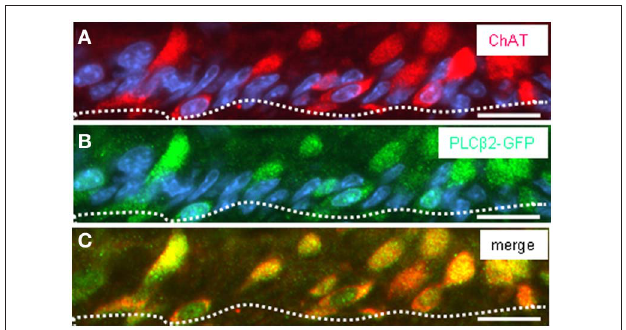
FIGURE 8 | Double-immunohistochemicalstaining visualizing ChAT protein in GFP-expressing cells of transgenic PLC β 2 promoter-GFP mice. (A–C) Analysis of ChAT immunoreactivity ( red ) pattern in relation to GFP staining pattern ( green ) on cross sections through the corpus mucosa at the fundus/corpus boundary of transgenic PLC β 2 promoter-GFP mice. (A) Numerous cells of the most apical mucosal cell layer (defined by the white dotted line ) are immunoreactive for ChAT. For several cells, the cross sectioned elongated apical pole appears as round-shaped structure. Staining with the GFP antibody (B) reveals many immunoreactive cells similar to the ChAT distribution pattern in (A) . Overlay (C) of (A) and (B) reveals coexpression of ChAT and GFP in a subset of corpus mucosal cells. Sections were counterstained with DAPI ( blue ). Scale bars : (A–C) = 20 μ m.